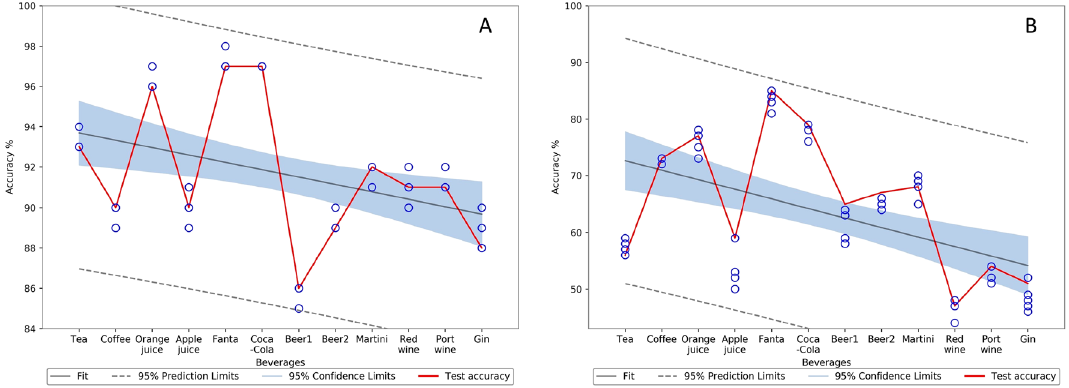
Figure 15. Paper4 confidence interval (CI) plot for beverage aging classification, ( A ) represents CI for SVM only and ( B ) represents CI for SVM with